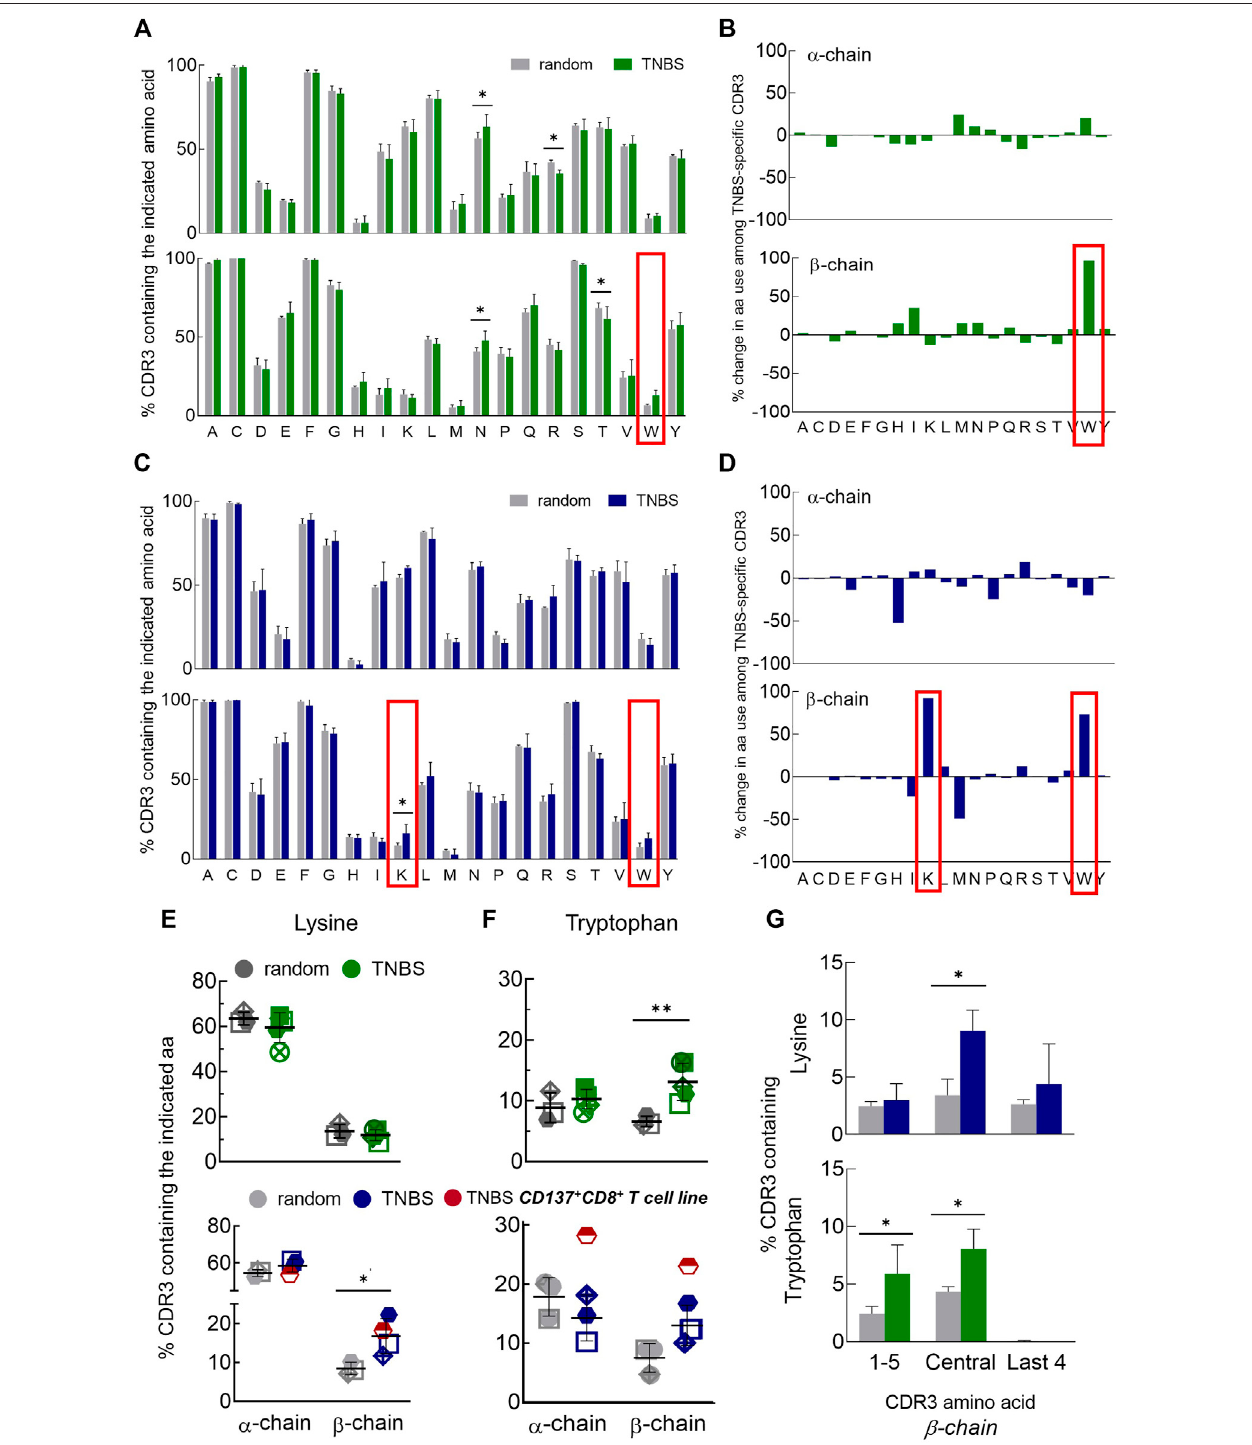
FIGURE3| Changesin CDR3amino acidcompositionamongTNBS-speci fi cTCR.TNBS-speci fi cCD154+CD4+ and CD137+CD8+memory Tcells weresorted from 5 to 16 h experiments, respectively, and their TCR were sequenced ( Supplementary Table S3 ). Random CD4+ and CD8+ memory T cells from the same buffy coatsservedascontrol. (A,C) CDR3aminoacidcompositions.ThebarchartsdepicttheoccurrenceofindividualaminoacidsintheCDR3ofTCR α -(upperpanel)and β - chains (lower panel) in single letter code for random (white) and TNBS-speci fi c CD154+CD4+ [green, (A) ] or CD137+CD8+ [blue, (C) ] T cells, respectively (mean values, TCR diversity, n = 3 – 5). The fi rst C and last F of the CDR3 have been included in the analysis. The red box indicates the most prominent changes. (B,D) Percent